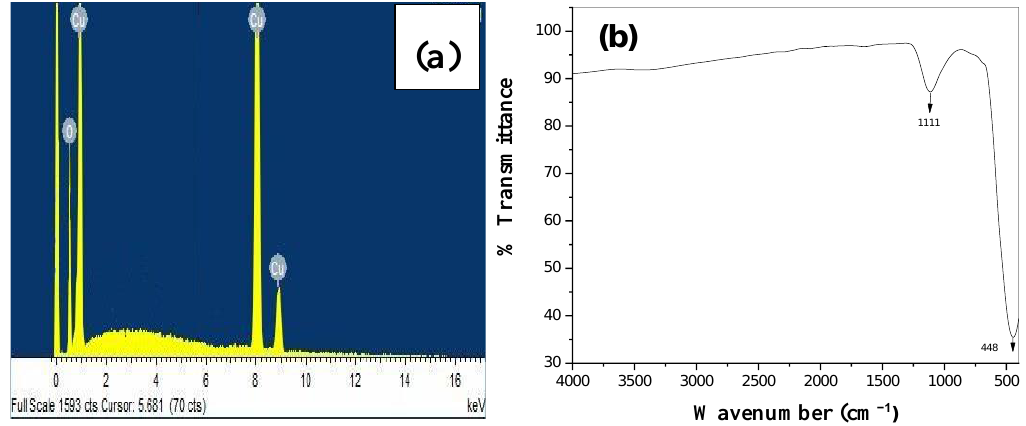
Figure 4. EDX spectrum ( a ) and FTIR spectrum ( b ) of B. ciliate mediated CuO NPs.